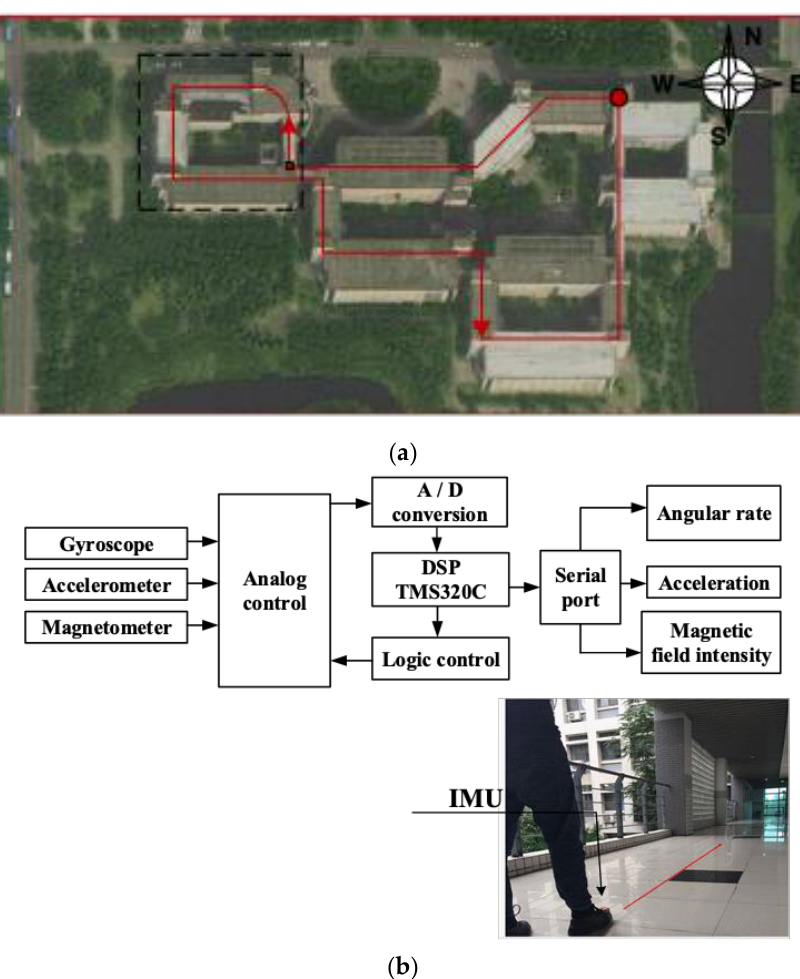
Figure 6. ( a ) Satellite image of the experimental site ( b ). Inertial measurement unit (IMU) structure and installation diagram.